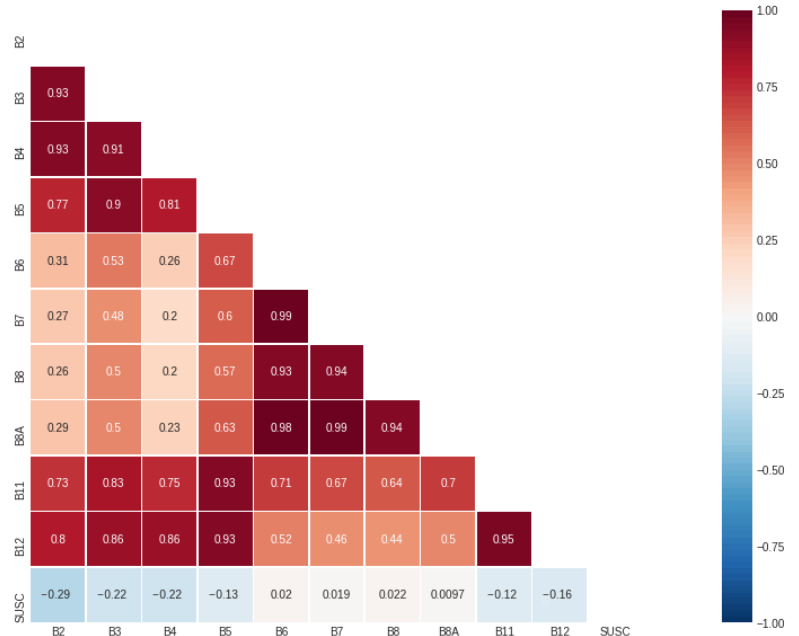
Figure 5. Correlations between bands (B2–B8, B8A, B11, B12) and the susceptibility label